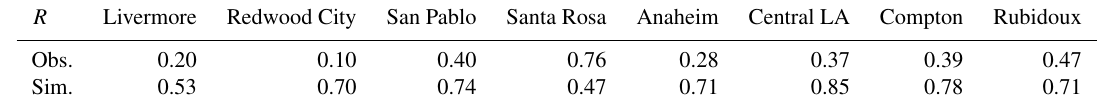
Table 2. Daily average correlation ( R 2 ) between PM 2 . 5 mass and particle number concentration at eight sites in California. R